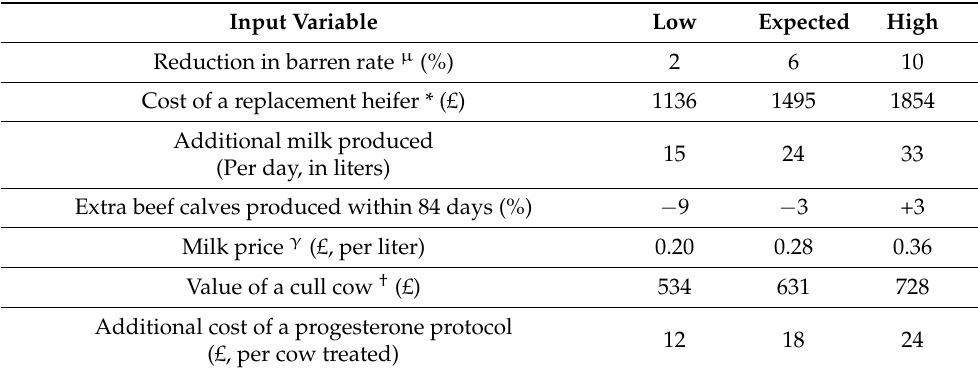
Table 2. Key input variables identified during sensitivity analysis. Variation between the low and high figures of these variables resulted in >1% change in the net benefit